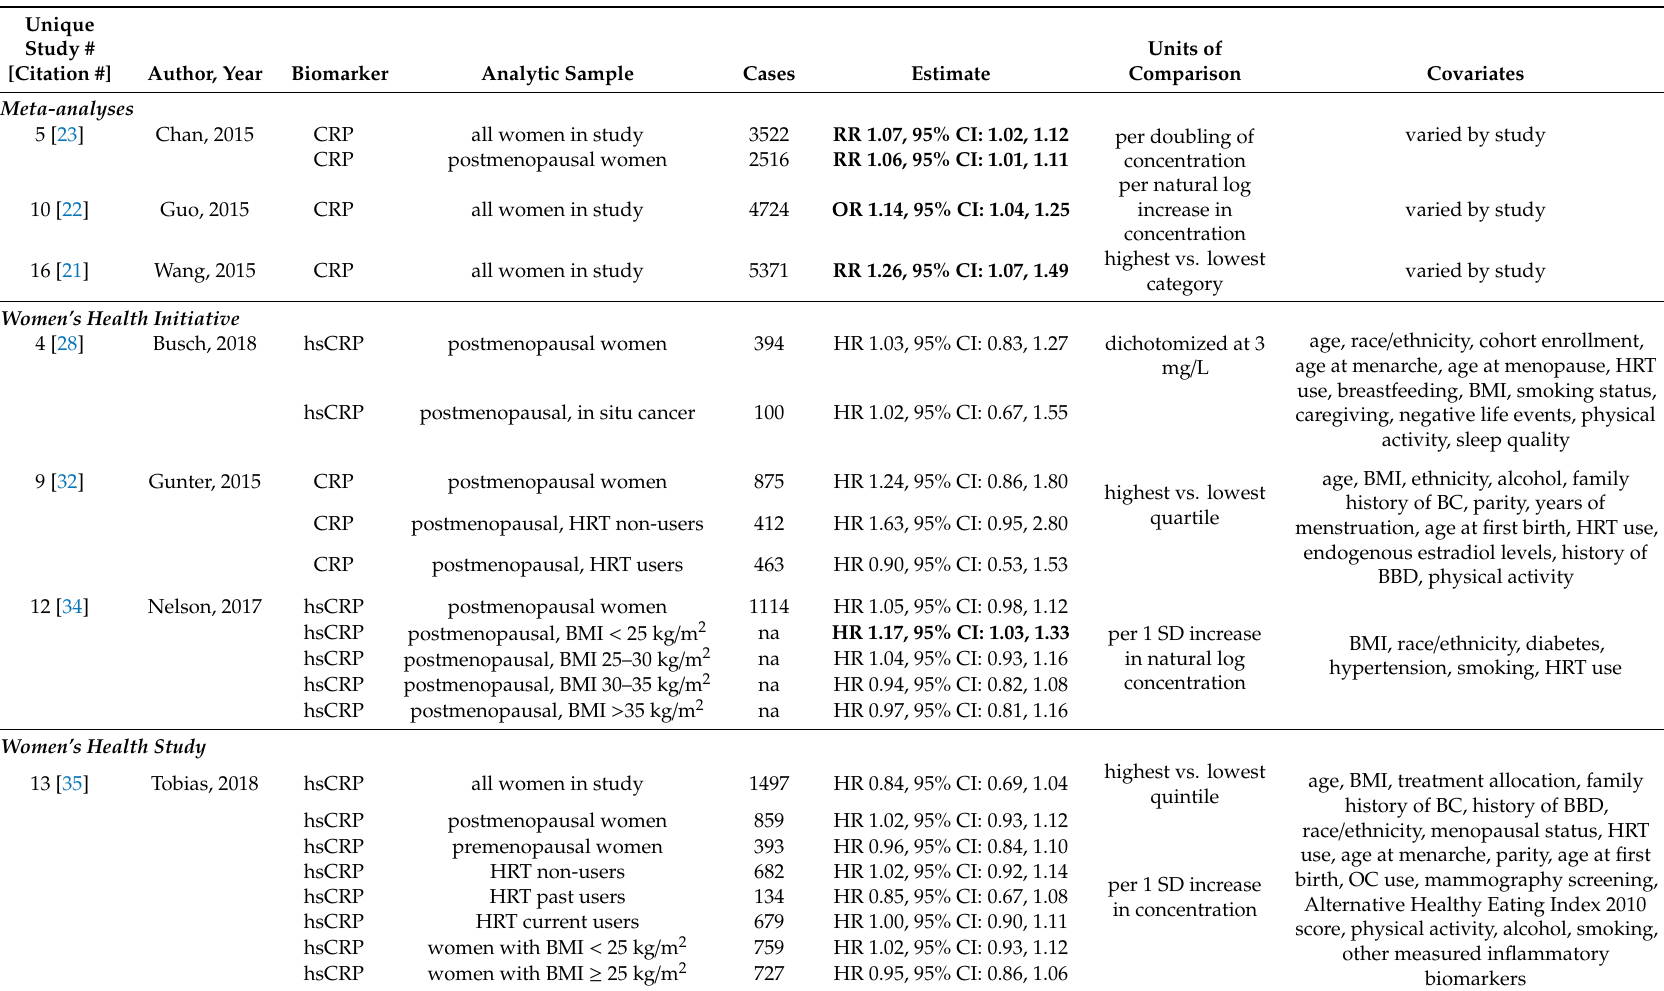
Table 2. Association of C-reactive protein (CRP) measured in blood with breast cancer risk from studies published January 2014 to April 2020 in PubMed. Unique Study